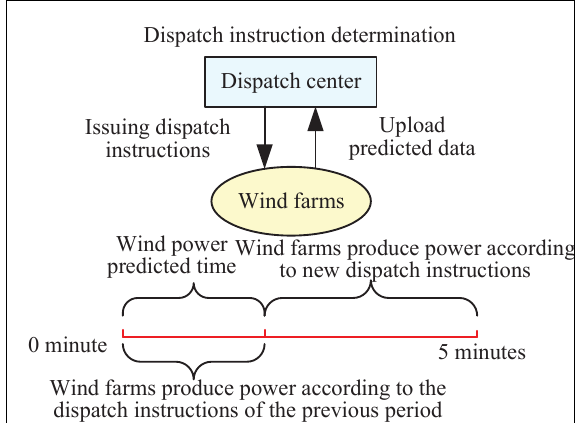
Figure 4. Wind power dispatch analysis on a temporal